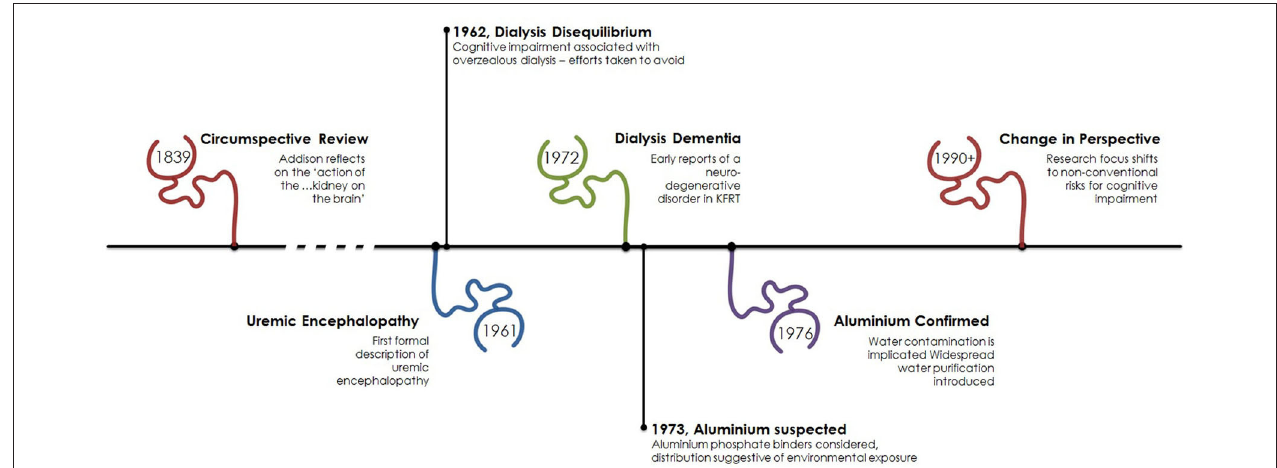
FIGURE 1 | Timeline of cognitive impairment in kidney failure. The association of cognitive impairment and kidney disease has been recognized for some time with early focus on the neurotoxic effect of kidney failure. Following the advent of dialysis the process of dialysis was responsible for cerebral dysfunction as a result of its own associated initially unrecognized neurotoxin, aluminum. From the early 1990s focus has turned toward other factors associated with kidney failure such as anemia and new dialysis-specific effects.